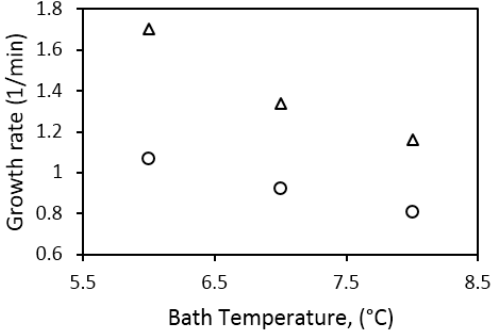
Figure 17. Effect of reactor size on gas hydrate growth at a gas-water volume ratio, V G /V L , of 1.828 (cf. Table 1) and at different experimental temperatures (700 rpm).